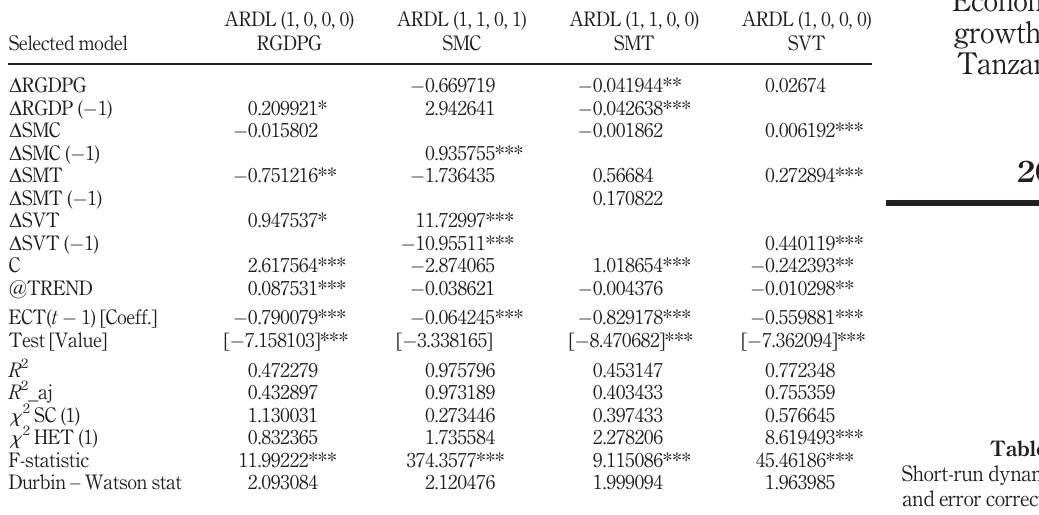
Table 5. Short-run